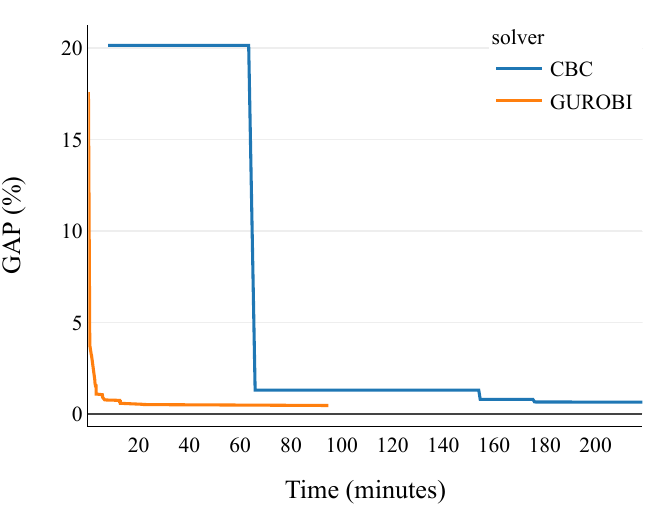
Figure 8. Time solution with different GAP in CBC and GUROBI solvers.